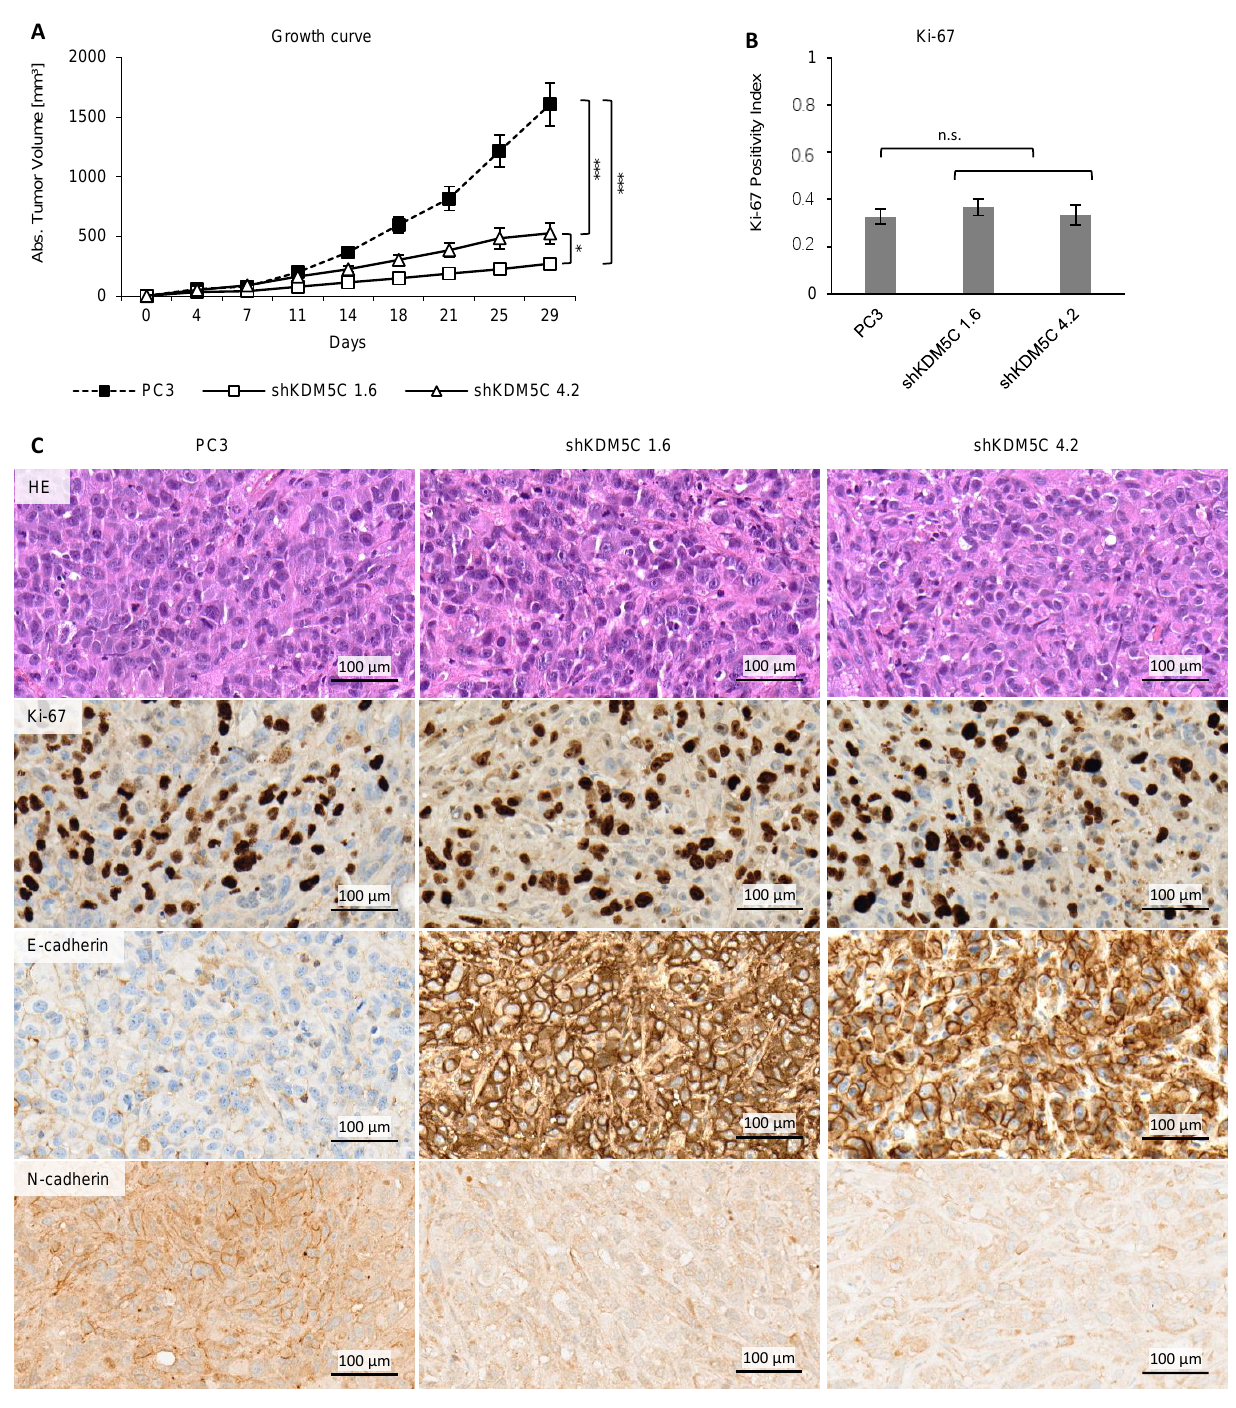
Figure 7. Comparison of mouse xenografts of PC3 wild type and KDM5C knockdown cells. ( A ) Growth curve of PC3 and shRNA-transduced cell tumors in mice xenografts. Error bars represent standard error of the mean from ten independent experiments. Tumors in mice receiving KDM5C knockdown cells were smaller than tumors of wild-type cells; ( B ) Index of Ki-67 positive cells in mice xenografts with PC3 and shRNA-transduced cells. Error bars represent standard error of the mean from eight independent experiments; ( C ) Representative samples of hematoxylin-eosin (HE) staining, as well as Ki-67, E-cadherin and N-cadherin protein expression in PC3 and shRNA-transduced cell mice xenografts. (n.s. = not significant; * = p < 0.05; *** = p < 0.001).